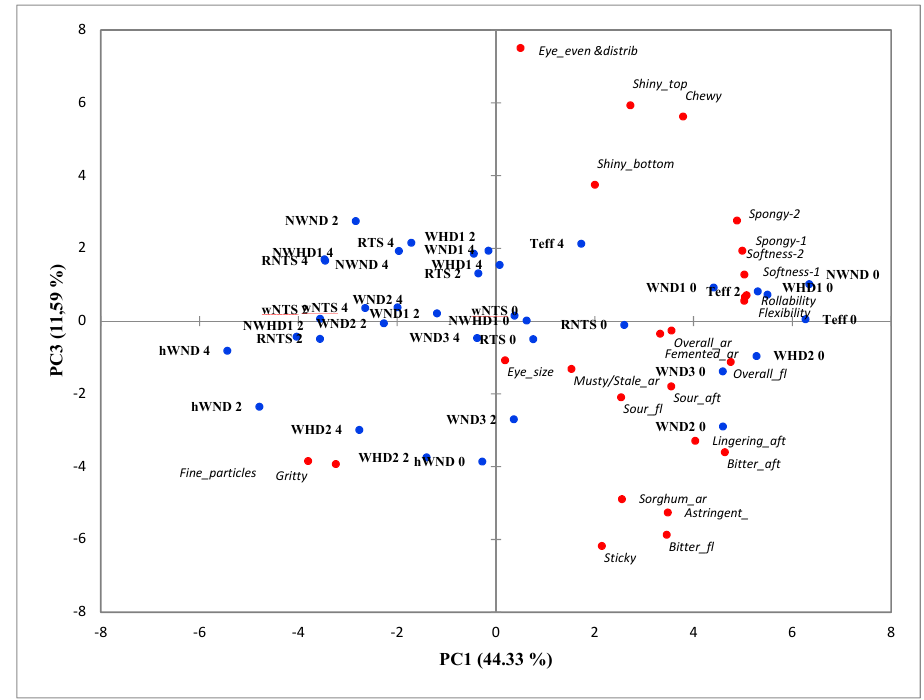
Figure 1. Principal component analysis (PCA) biplots (PC1, PC2, and PC3) of novel sorghum lines,